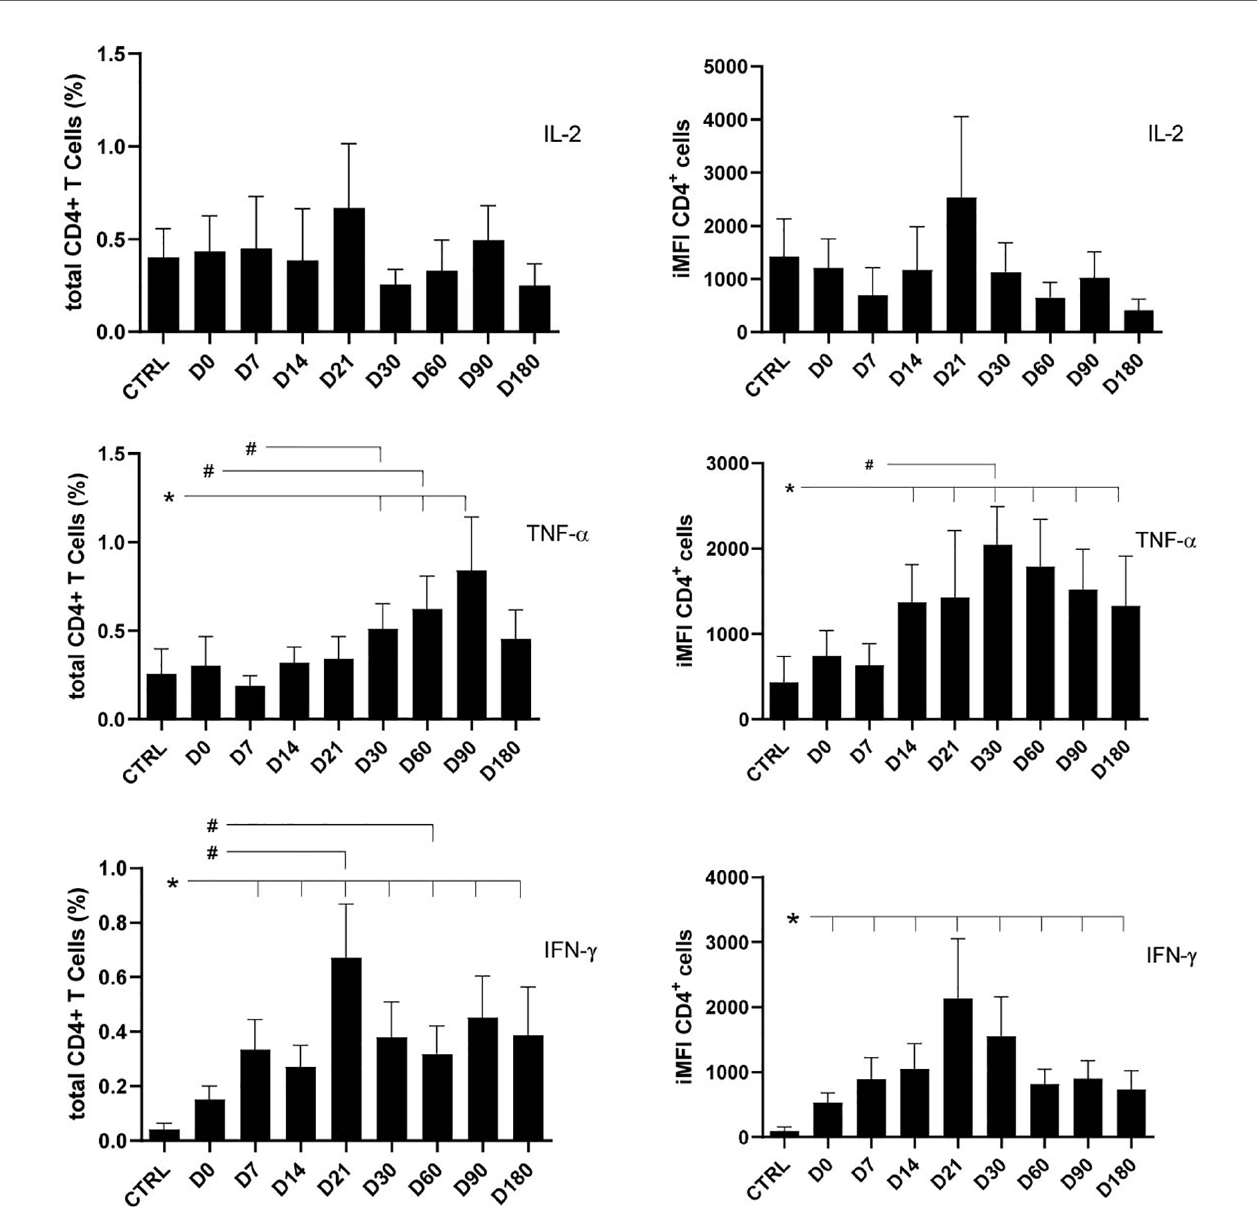
FIGURE 1 | Total frequencies and integrated mean fl uorescence intensity (iMFI) of cytokine-producing CD4 + T cells. The total frequencies and iMFI of each cytokine- expressing phenotype were determined in peripheral blood mononuclear cells (PBMCs) from healthy controls and patients before (D0) and during their treatment follow-up, after subtracting the background values corresponding to cells incubated without the soluble Leishmania antigen (SLA). Results in the panel are expressed as means+SE. Asterisks and horizontal lines indicate signi fi cant differences between times of treatments and healthy control records as disclosed by the Mann – Whitney method. Hashtags show signi fi cant differences between times of treatment as determined by the Wilcoxon matched-pairs rank statistical